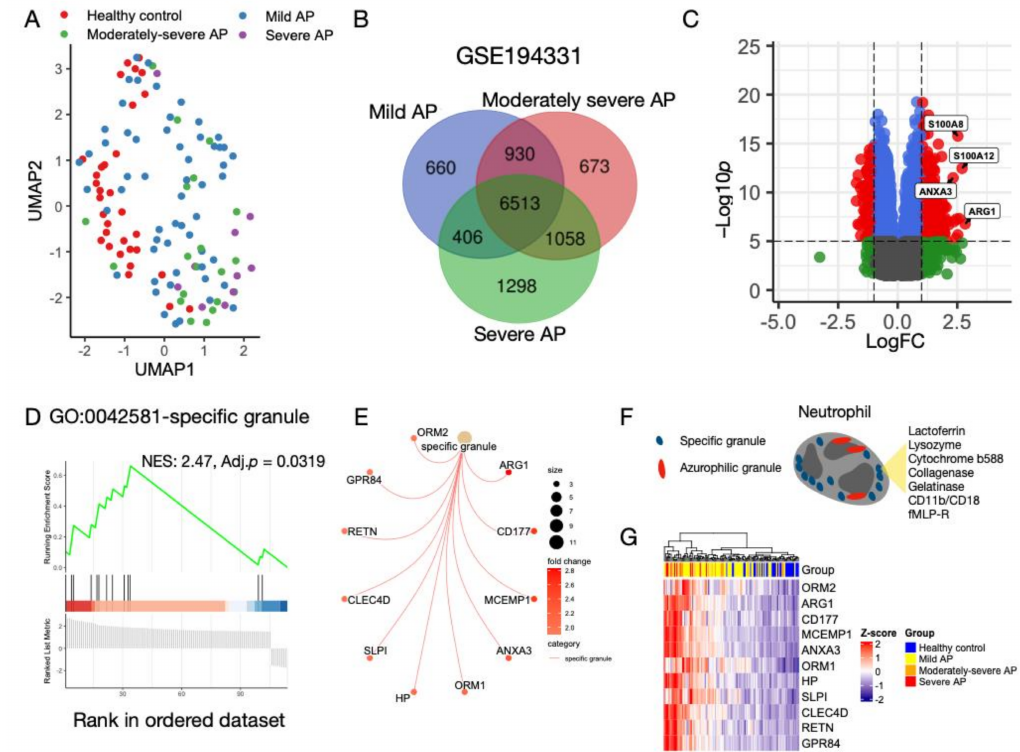
Figure 1. Characterization of gene expression profile in patients with non-chylomicronemia syndrome (CS)-associated acute pancreatitis (AP). ( A ) Uniform manifold approximation and projection (UMAP) plot of gene expression between AP samples and healthy controls in GSE194331. Patients with AP are divided into mild, moderately severe, and severe. Red: Healthy control. Blue: Mild. Green: Moderately severe. Purple: Severe. ( B ) Venn diagram of differentially expressed genes (DEGs) among three degrees of severity in GSE194331. There are 6513 common DEGs. ( C ) Volcano plot of the common DEGs in the Venn diagram. Red: Significantly up-regulated and down-regulated